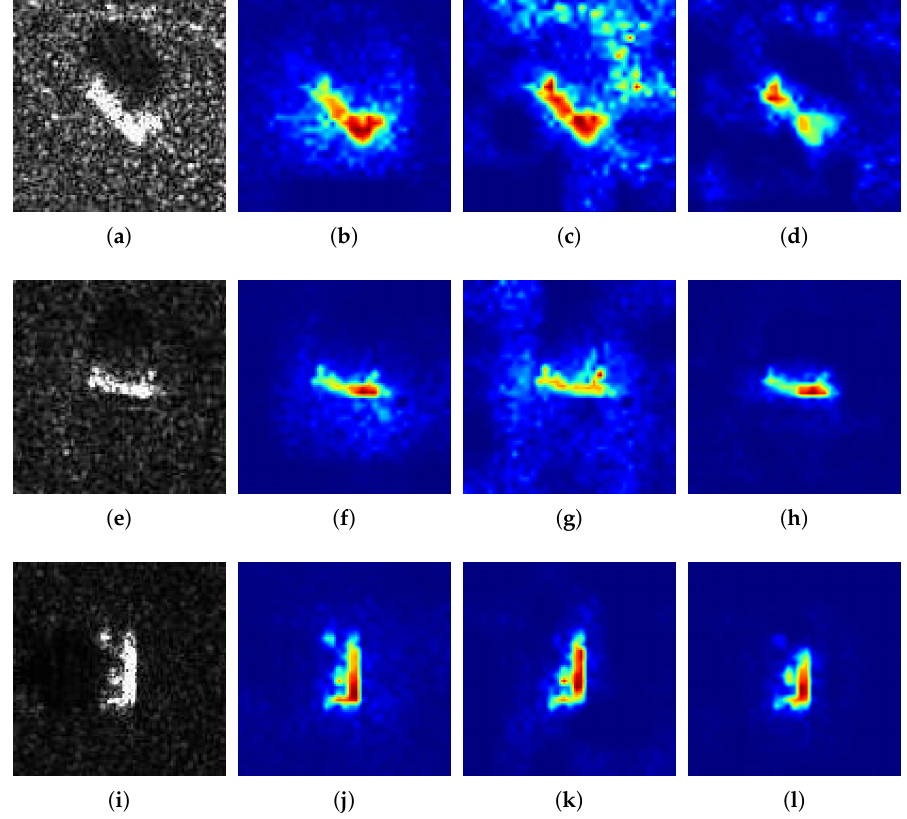
Figure 6. Experimental results for AlexNet, VGG16, and VGG19. In the first column ( a , e , i ) is SAR images for 2S1, BRDM_2, and SN_132, respectively. The second column ( b , f , j ) is corresponding CAM heatmaps for AlexNet. The third column ( c , g , k ) and fourth column ( d , h , l ) are corresponding CAM heatmaps for VGG16 and VGG19,